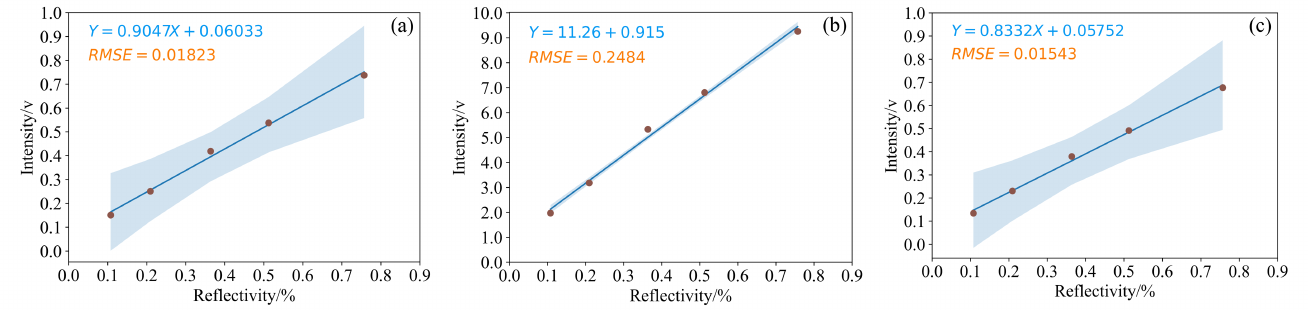
Figure 7. Fitting result of BRF and laser echo intensity. ( a ) Relationship of BRF and the echo peak value, ( b ) relationship of BRF and the echo integral value, and ( c ) relationship of BRF and the amplitude of the echo’s centroid.